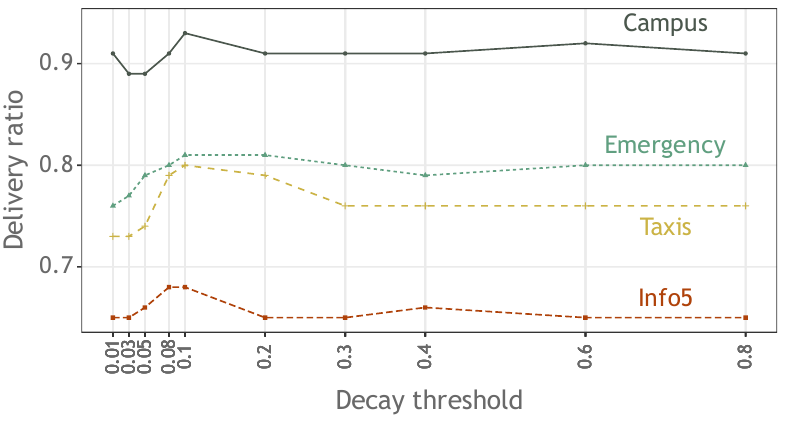
Figure 18. Delivery ratio for different decay thresholds